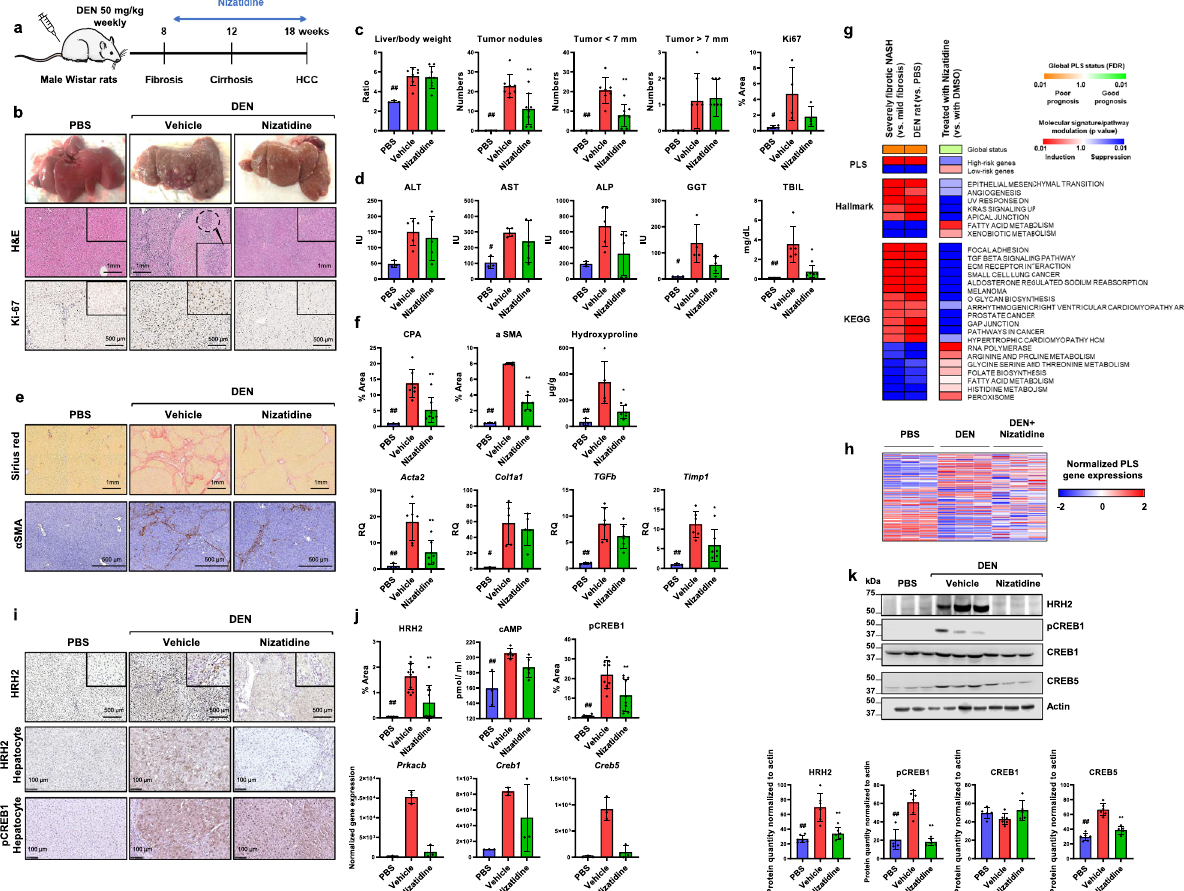
Fig. 4 In vivo proof-of-concept of nizatidine for treatment of liver fi brosis progression and HCC chemoprevention. a – d Nizatidine alleviates carcinogenesis in cirrhotic livers. a DEN-injured male Wistar rats received vehicle control or nizatidine for 10 weeks. PBS, n = 3; DEN + vehicle, n = 7; DEN + nizatidine, n = 8. b Representative morphometric analysis (hematoxylin and eosin (H&E)) of liver slices are shown (original magni fi cation ×5). The number and size of macroscopic tumors were reported in c . Surrogates used for tumor burden include liver/body weight ratio and number of surface tumor nodules. Cell proliferation was assessed by the IHC evaluation of the proliferation marker Ki-67 in liver tissues. d Measurement of serum transaminases (alanine aminotransferase (ALT), aspartate aminotransferase, (AST) alkaline phosphatase (ALP), gamma-glutamyl transferase ( γ GT) activity, and of